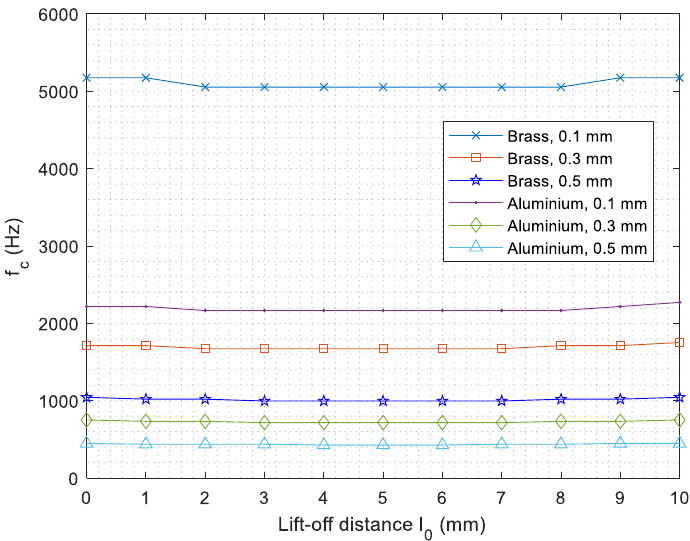
Figure 9. Lift-off insensitive frequency versus lift-off distance for different coatings.